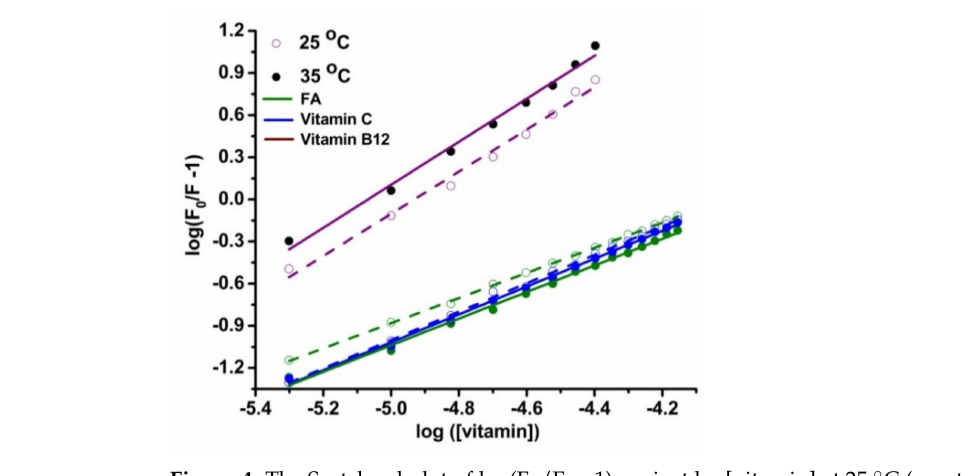
Figure 4. The Scatchard plot of log(F 0 /F − 1) against log[vitamin] at 25 ◦ C (empty circles) and 35 ◦ C (full